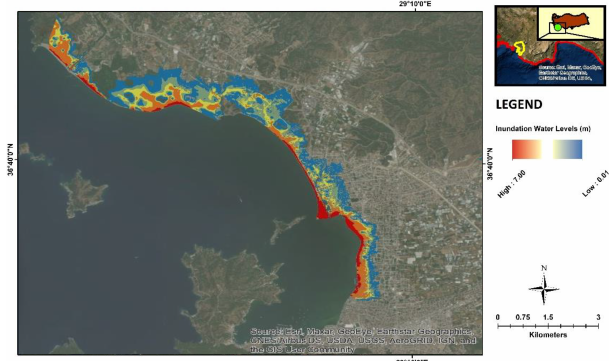
Figure 12. Inundation levels obtained from the simultaneous oc- currence of fully developed flood Q 10 and earthquake-triggered tsunami hazards (sources: Esri, Maxar, GeoEye, Earthstar Geo- graphics, CNES/Airbus DS, USDA, USGS, AeroGRID, IGN, and the GIS User Community).